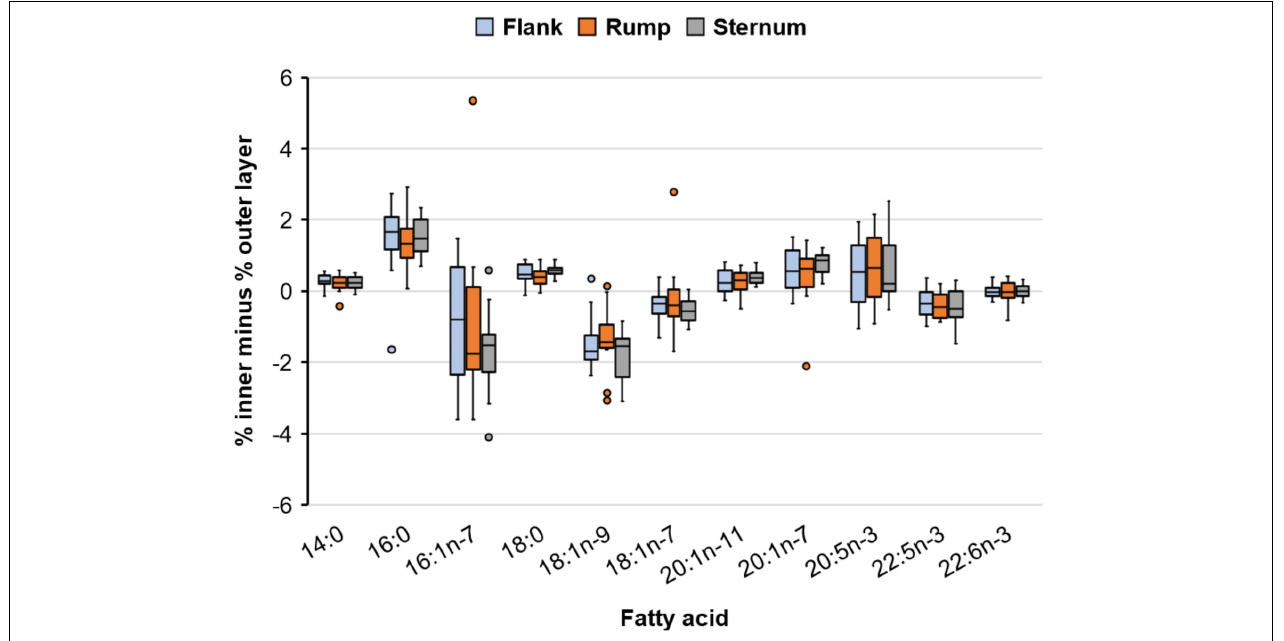
FIGURE 3 | Observed differences in percent abundance of major fatty acids between inner and outer blubber layers among three body sites of 15 lactating Pacific walruses in spring 2007 (plots indicate median, 25th and 75th percentile (box), and minimum and maximum (whiskers) excluding outlier points which are beyond 1.5 times the interquartile range).